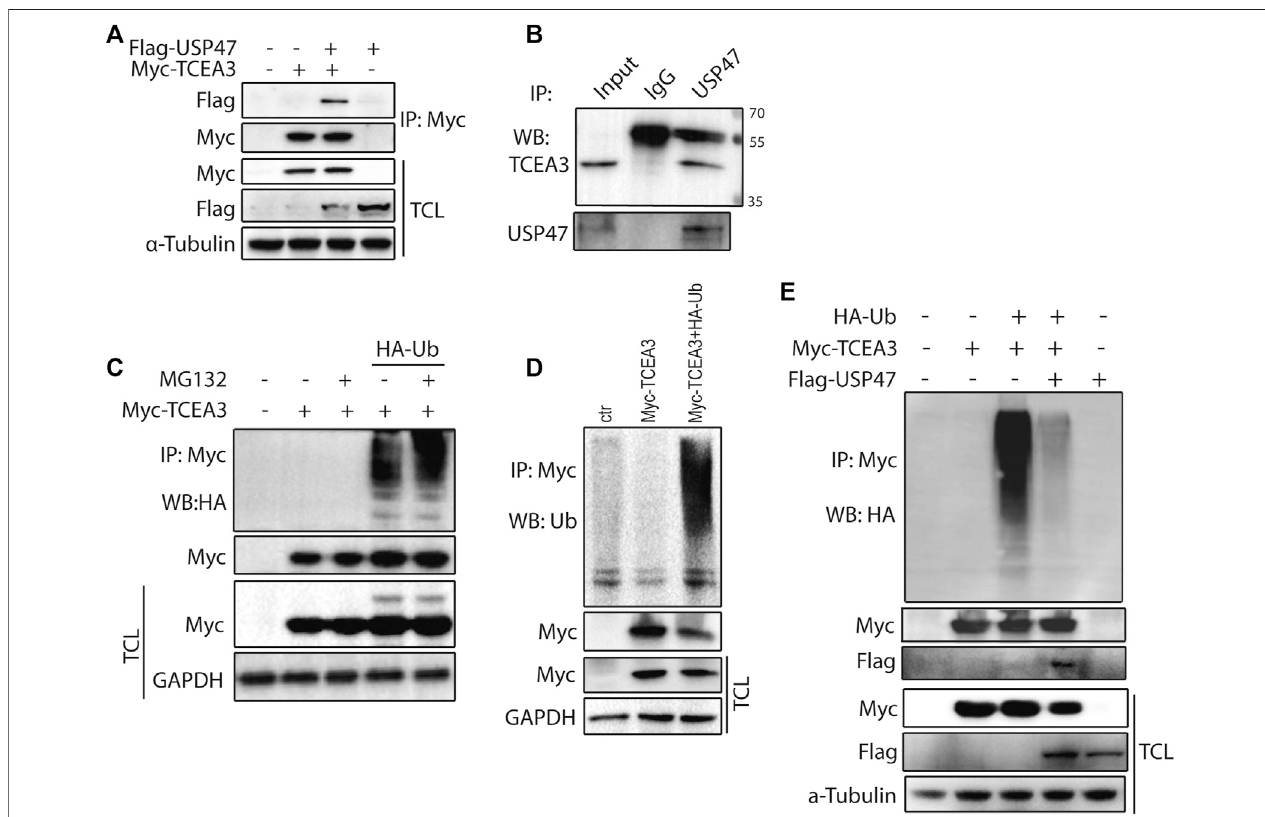
FIGURE4| USP47actsasadeubiquitinatingenzymeofTCEA3. (A) co-immunoprecipitationofoverexpressedUSP47andTCEA3.Flag-USP47andMyc-TCEA3- expressing plasmids were transfected into HEK293T cells for 48 h. Total cell lysate was immunoprecipitated with anti-Myc antibody and blot with anti-Flag antibody. Total cell lysates were also directly blotted with the antibodies. (B) The interaction of endogenous USP47 and TCEA3. Lysates from HCT116 cells were immunoprecipitated with anti-USP47 antibody and blotted with anti-TCEA3 antibody (C, D) The ubiquitination of TCEA3. Myc-TCEA3 and HA-Ub plasmids were transfected into HEK293T cells for 48 h. After exposed to 20 μ M of MG132 for 6 h, the cells were harvested, immunoprecipitated with anti-Myc antibody, and blotted with anti-HA (C) or anti-Ub antibodies (D) . (E) USP47 decreased the ubiquitiantion of TCEA3. Flag-USP47, Myc-TCEA3 and HA-Ub plasmids were transfected into HEK293T cells for 48 h. Following treatment with 20 μ M of MG132 for 6 h, cell lysates were immunoprecipitated with anti-Myc antibody and blotted with anti-HA, anti- Myc or anti-Flag